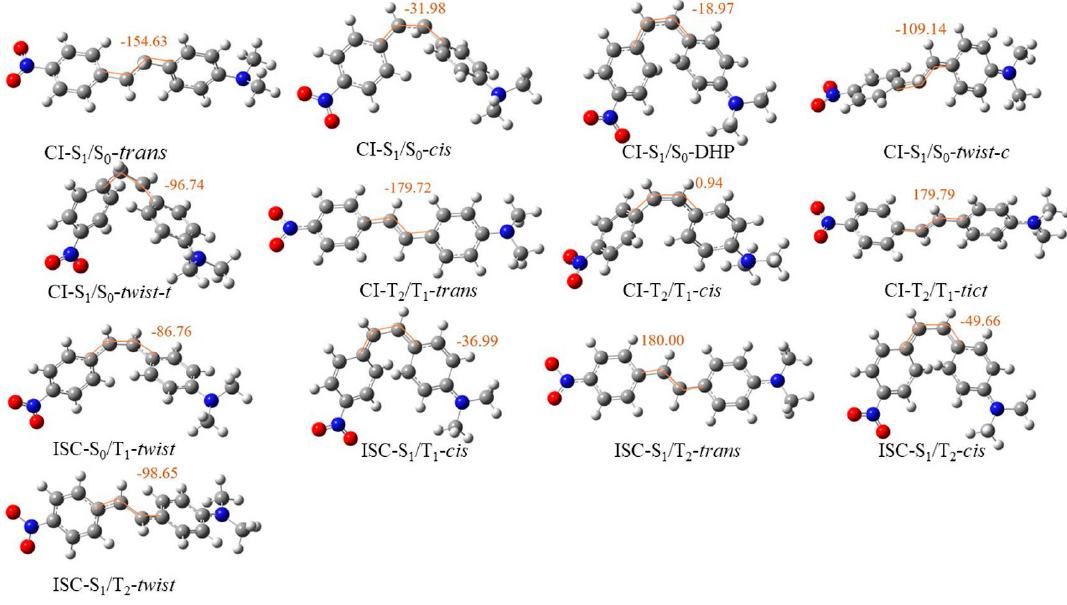
Figure 1. Geometries for SA6-CASSCF (18,12) optimized CIs and ISCs of DANS.